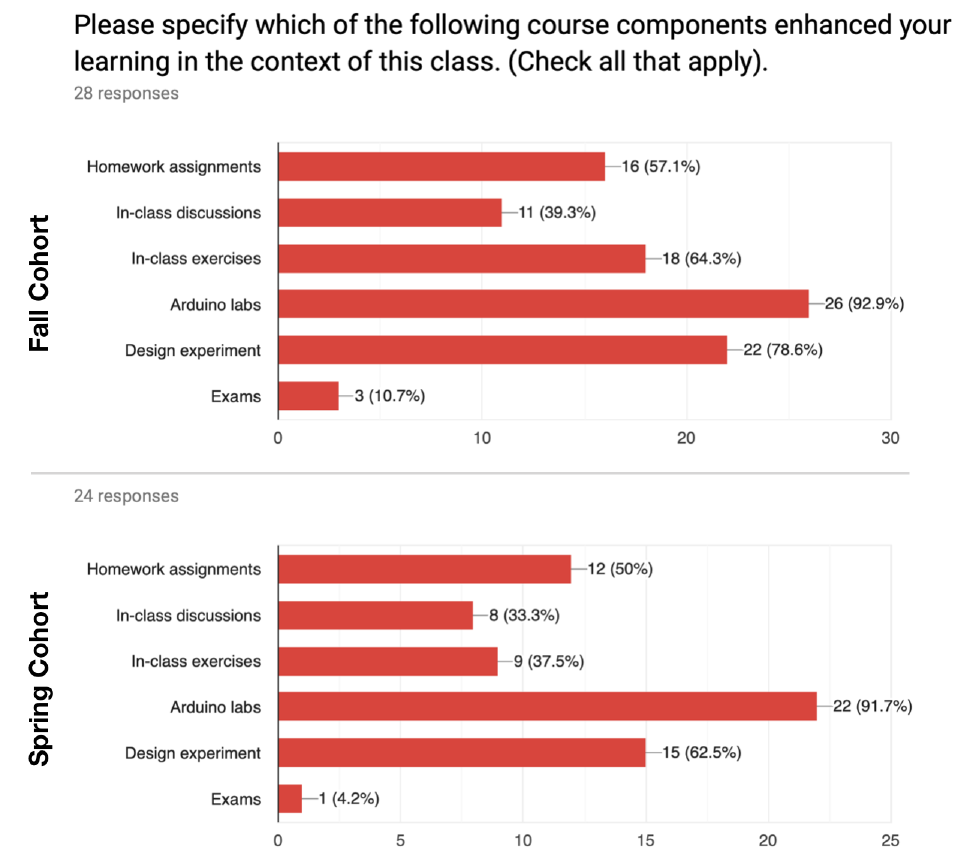
Figure 4. Student opinions on course components on learning enhancement, Fall 2016 and Spring 2017 cohorts. More than 90% of students picked hands-on modules (Arduino labs) as a component that enhanced their learning. The second most picked component was Design experiment (small project that students come up with and designed